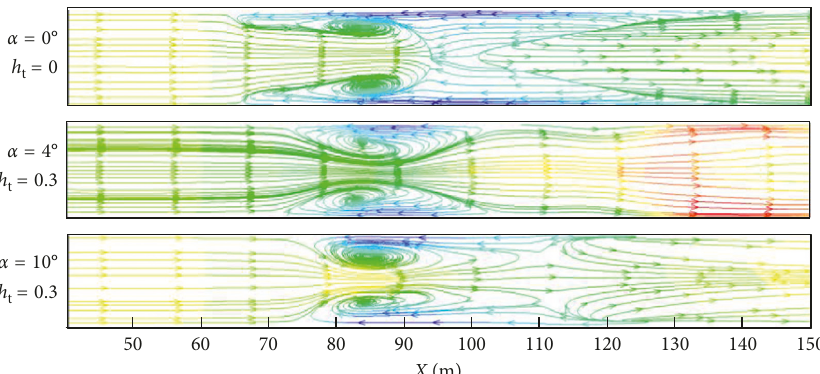
Figure 10: Local streamline distribution on X - Z plane for u � 3 m/s and Y � 0.5m.